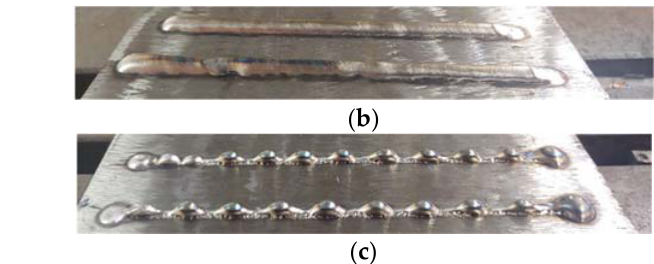
height and width of the bead (see Figure 5b). By contrast, the defective welding shows an uneven or wavy bead shape (see Figure 5c).